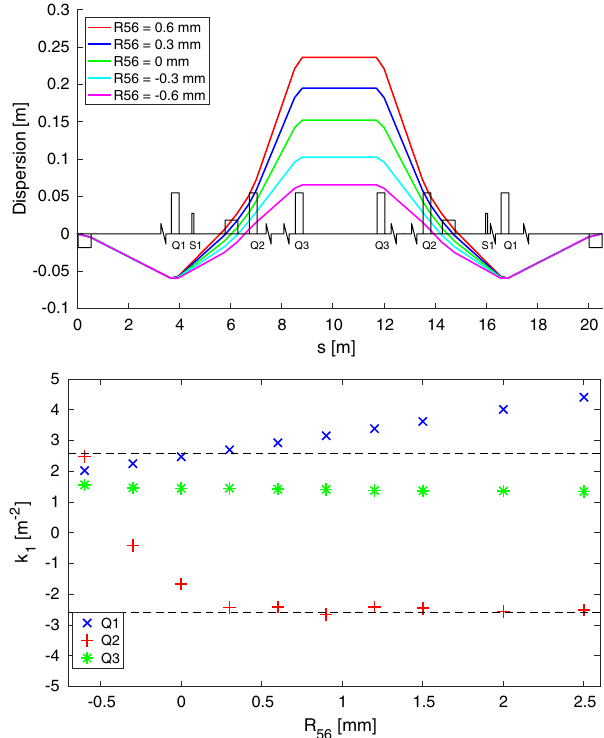
FIG. 3. Top: horizontal dispersion along the energy collimator for different values of R 56 . Bottom: settings of the three quadru- pole pairs (Q1, Q2, Q3) at the energy collimator for different values of R 56 . The dashed lines represent the present limits of the SwissFEL quadrupoles for 5.8 GeV.